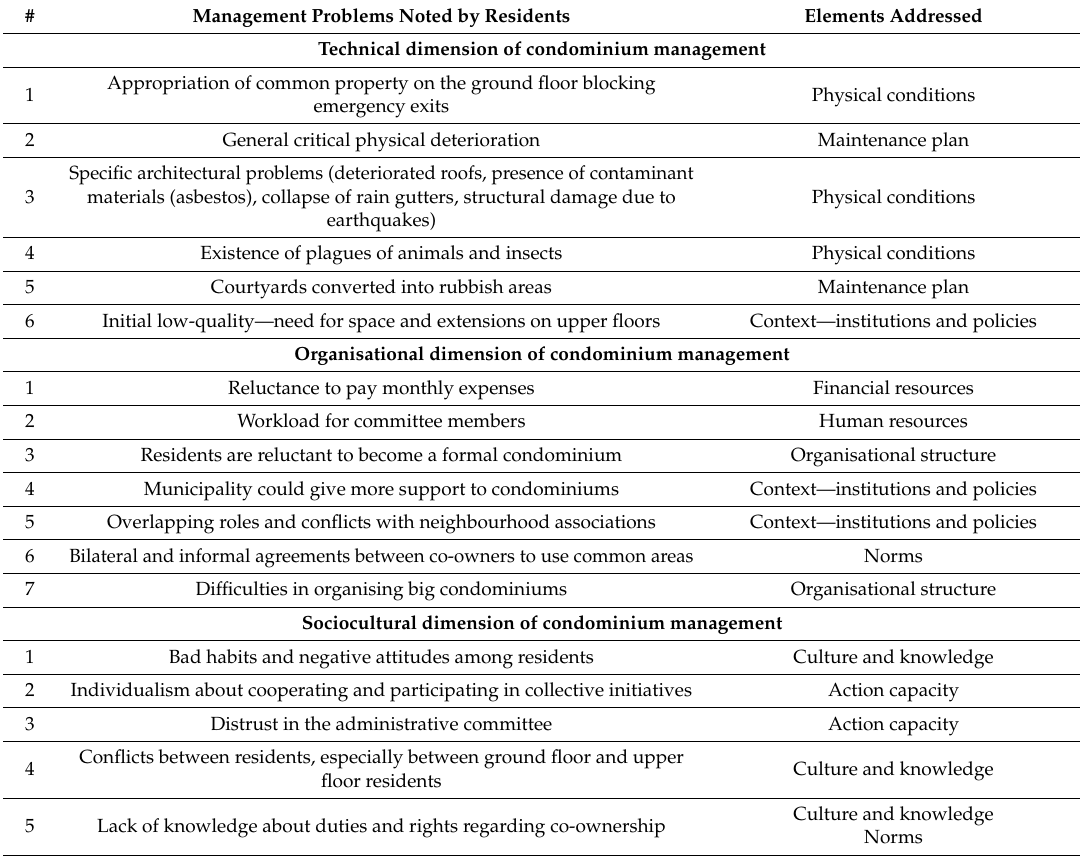
Table 6. Categorisation of management problems reported by the residents according to dimensions and